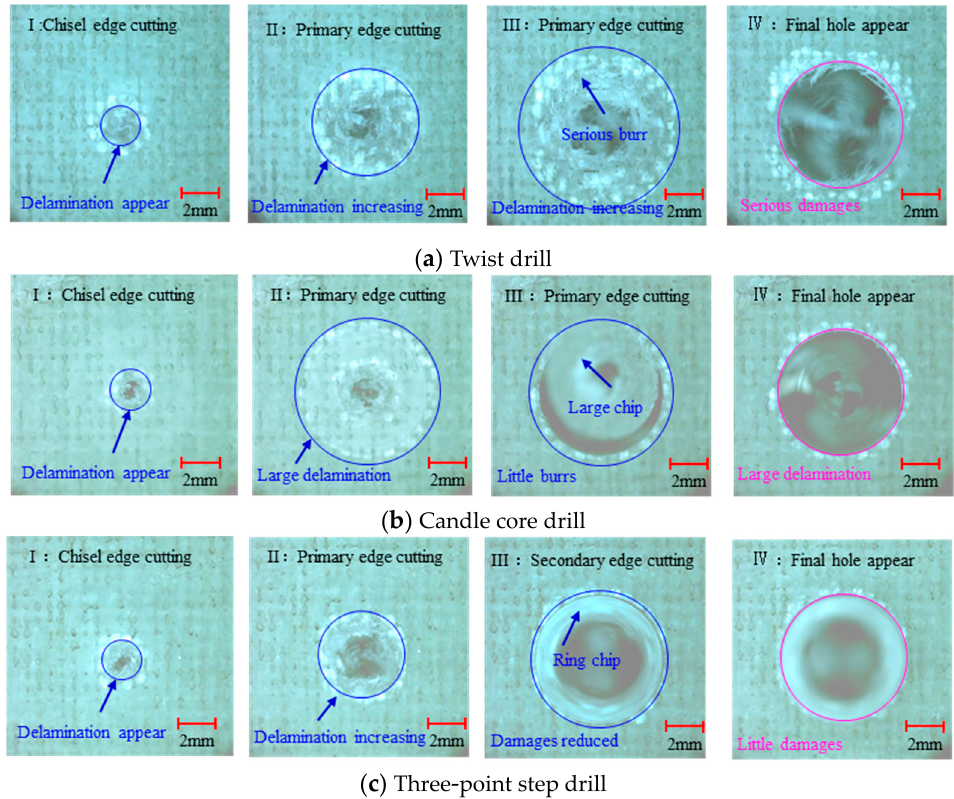
Figure 7. Drilling processes of three drills: ( a ) twist drill, ( b )candle core drill, ( c ) three-point step drill.